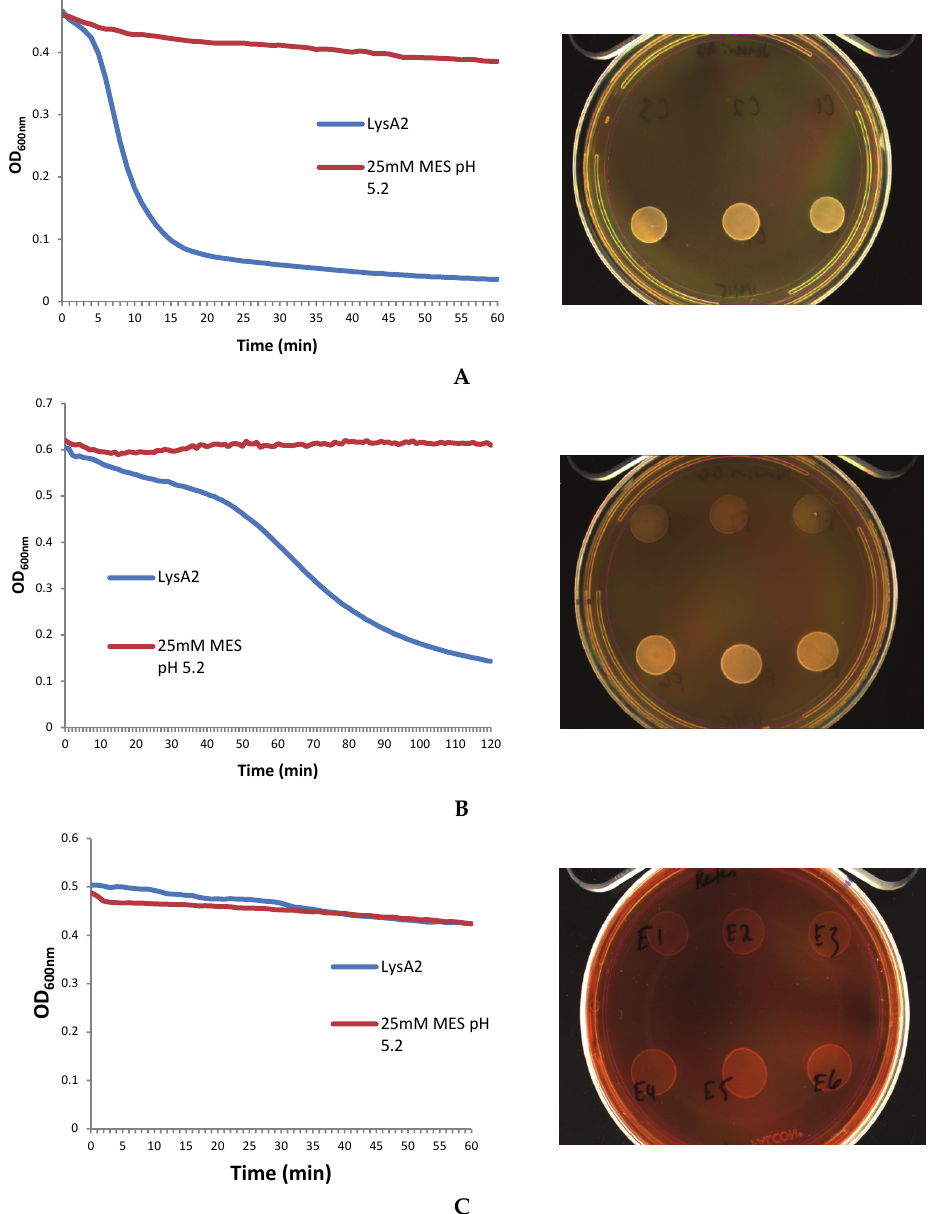
Figure 3. Correlation of lytic activity of LysA2 determined by reduction in OD 600 to cell viability on MRS plates. Samples from triplicate wells (experimental on the top row and buffer only controls on the bottom row) used in the lytic assay were spotted onto MRS agar (one spot from each well) and incubated for up to two days to determine cell viability. Images of Lactobacillus spots are shown to the right of the corresponding lytic assay. LysA2 lytic activity can be divided into three categories: ( A ) strong lytic activity of LysA2 on L. jensenii ; ( B ) oderate lytic activity of LysA2 on L. rhamnosus GG ; and ( C ) no lysis of L. reuteri by LysA2.